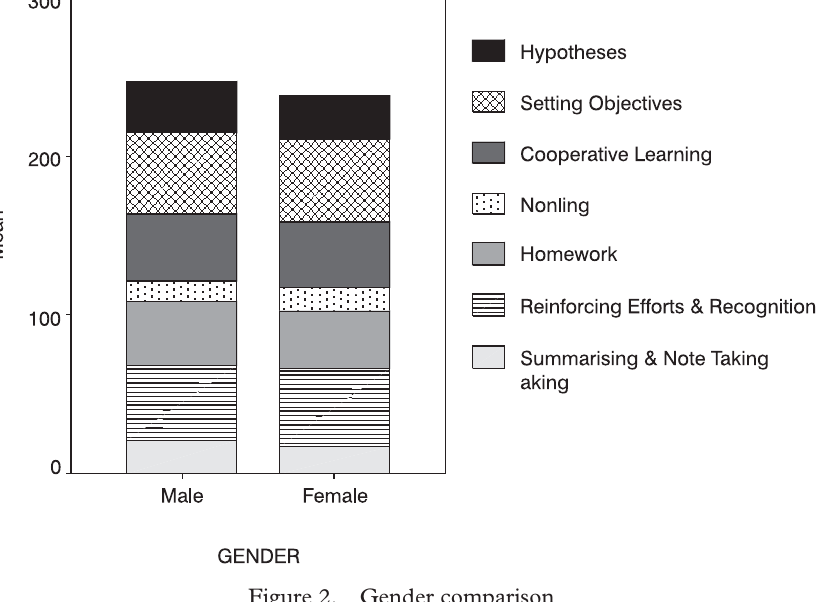
Figure 2. Gender